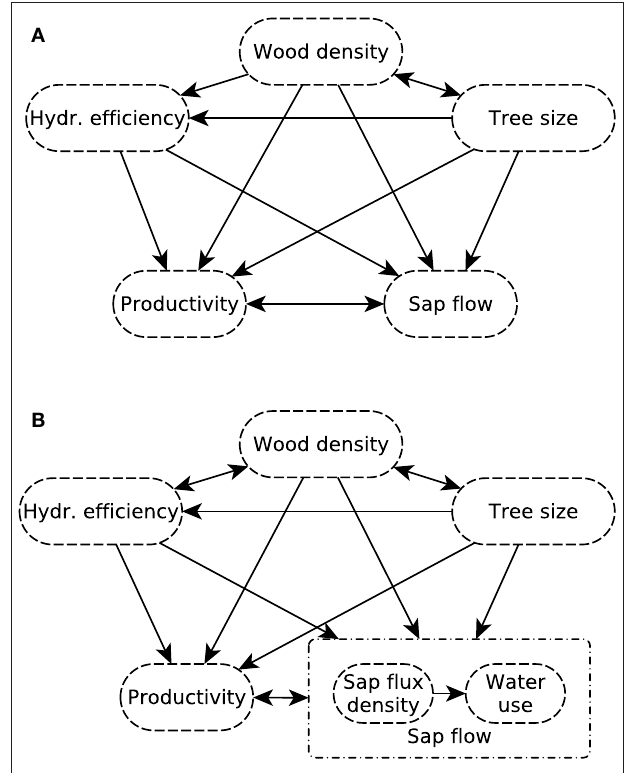
FIGURE 1 | (A) Initial and (B) revised meta-model of the causal relations amongst structural characteristics and hydraulic traits, water use, and productivity. Correlative relationships are indicated by double-headed arrows, while functional relationships are indicated by single-headed arrows.